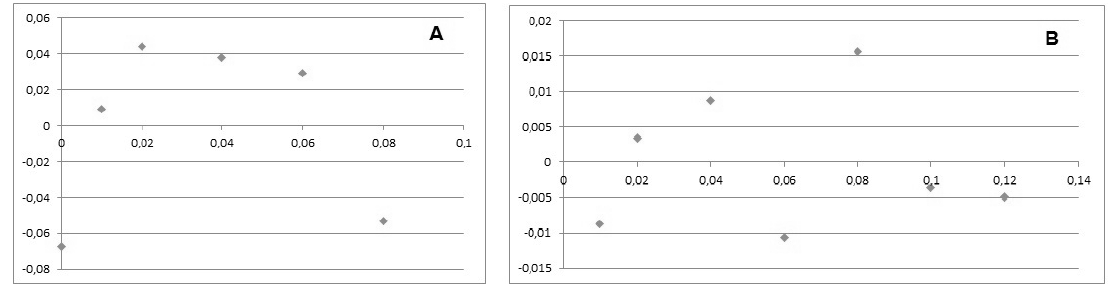
Figure 2. Residual deviation plot: ( A ) for Val-MEM as a nonlinear example; ( B ) for Ala-MEM. Respective comparisons between linear and second order polynomial calibration graphics for the same examples are presented in Figure 3.